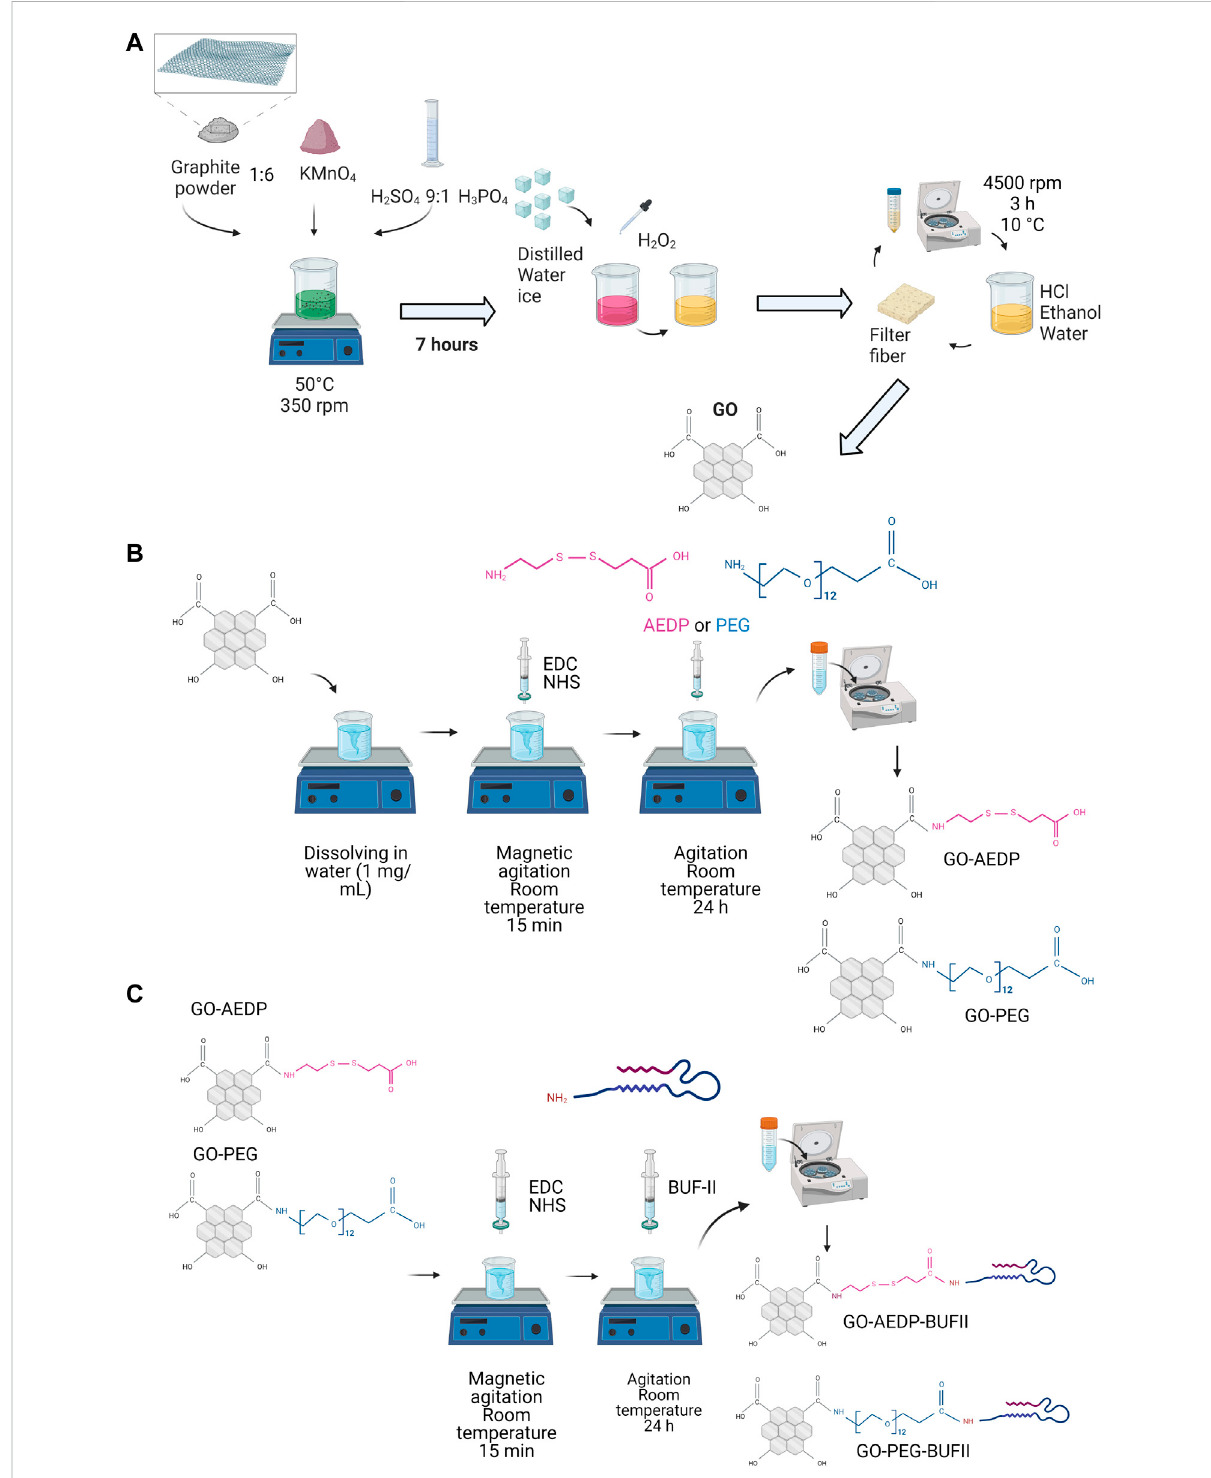
FIGURE 1 Schemeoftheexperimentalprocedureforconstructingthenanobioconjugates. (A) SynthesisofGO; (B) FunctionalizationofGOwithreducible and polymeric linkers; (C) Conjugation of BUFII. Figure created with BioRender.com.